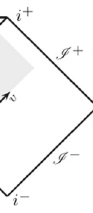
Fig. 1 The computational domain (marked gray) on the background of a dynamical Schwarzschild spacetime shown on the Carter-Penrose diagram. The central singularity along r = 0 and the event horizon are denoted as S and EH , respectively. I ± and i ± are null and timelike infinities, respectively, i 0 is a spacelike infinity